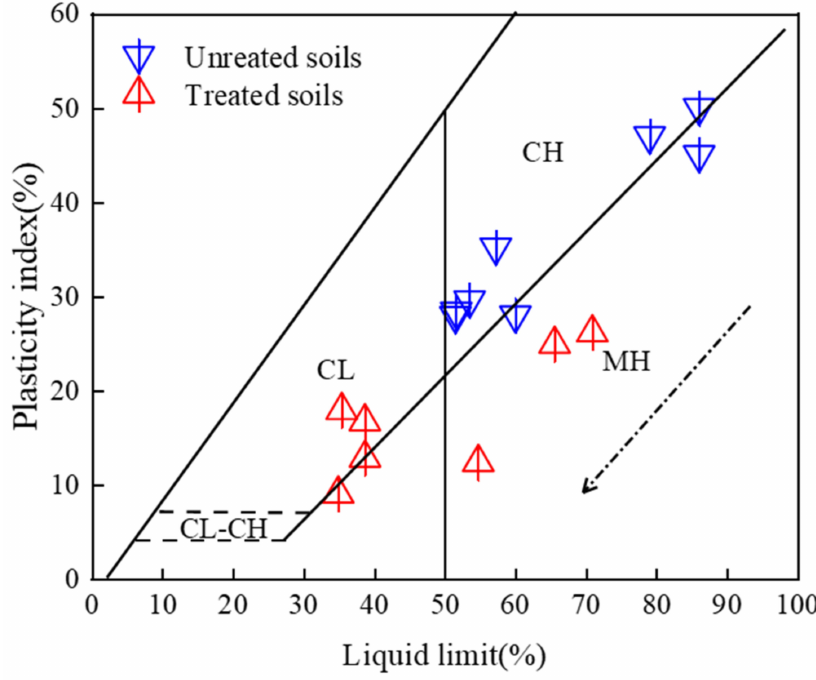
Figure 7. Classification of stabilized soil by different types of industrial solid